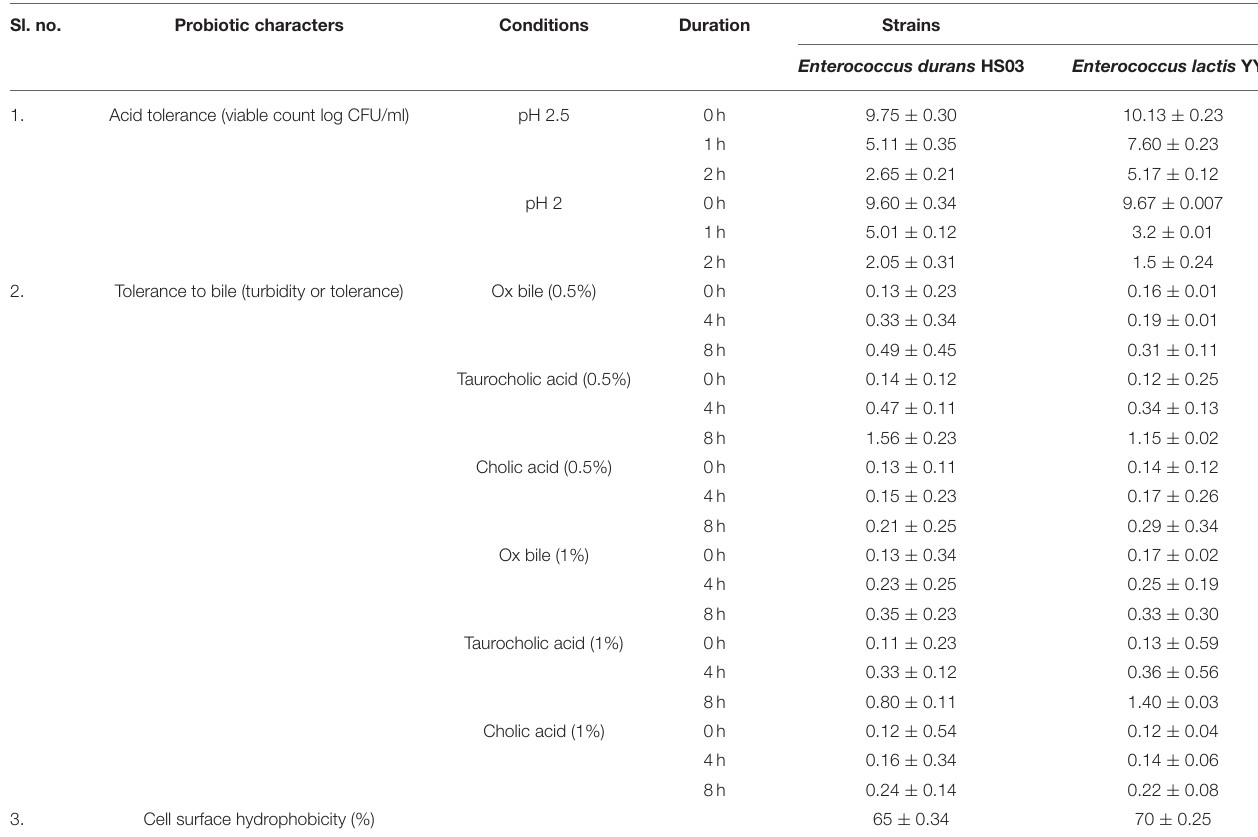
TABLE 3 | Probiotic attributes of Enterococcus durans HS03 and Enterococcus lactis YY1. Sl.